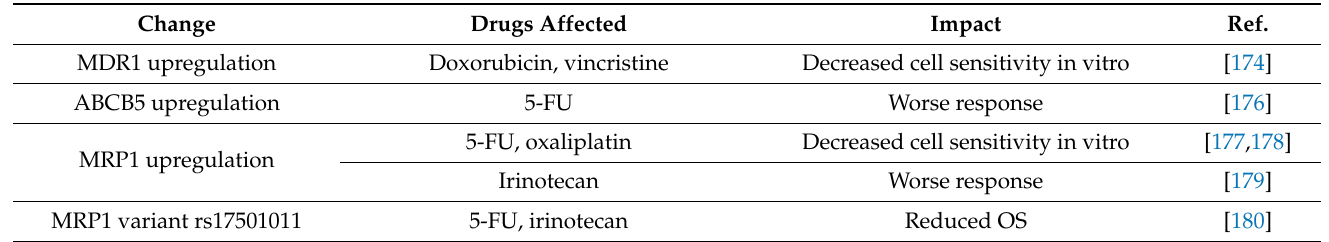
Change Drugs Affected